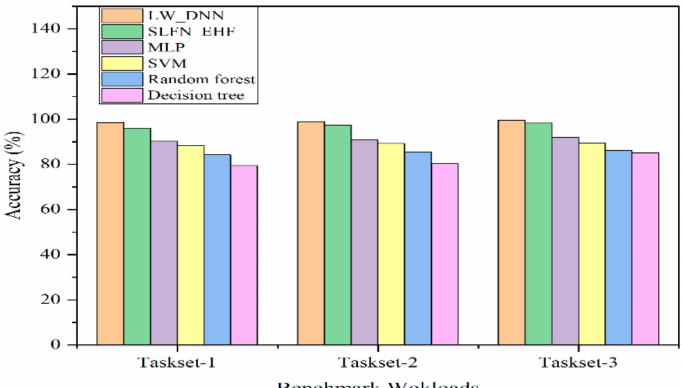
Figure 8. Prediction Accuracy for Benchmark workloads on Hardware Configuration 1.